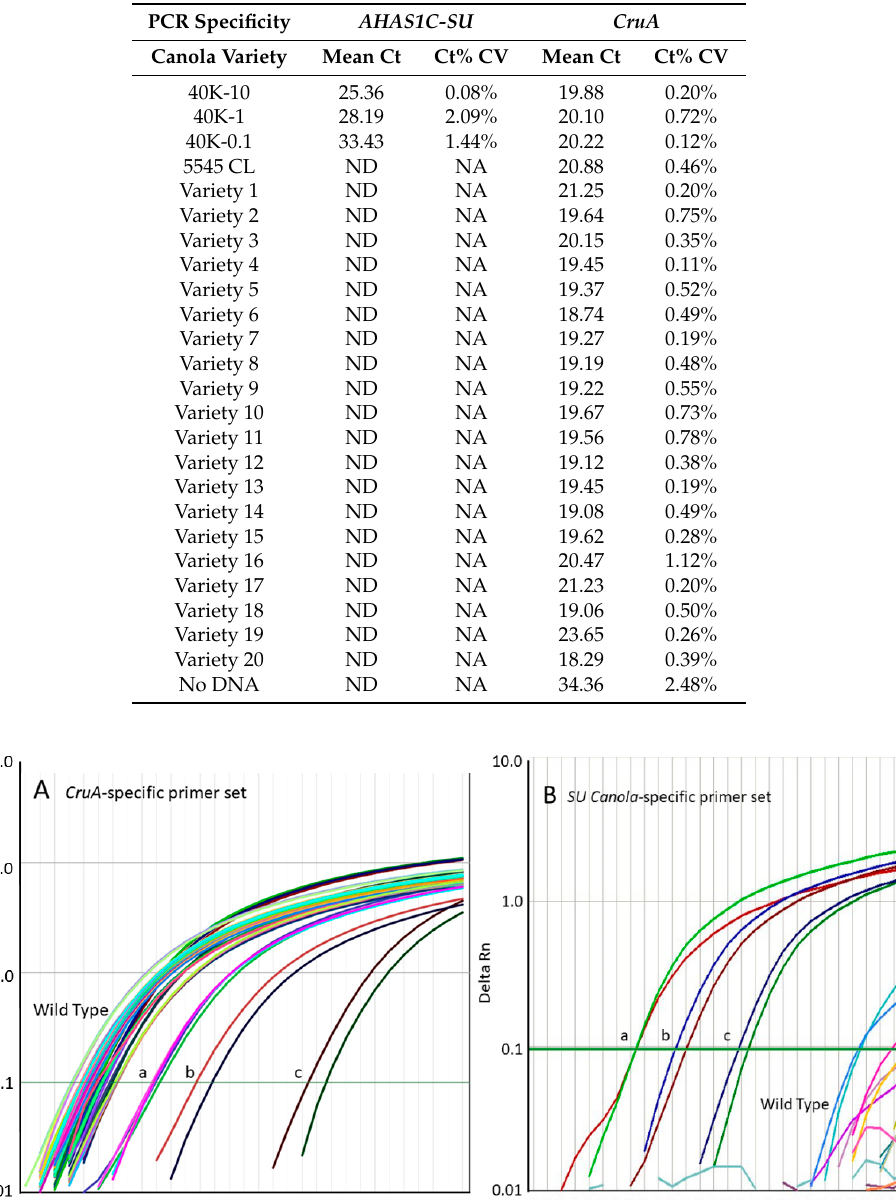
Table 3. Real-time qPCR amplification of DNA from SU canola event 40K, Clearfield canola variety 5545 CL and 20 varieties of wild-type canola with PCR systems specific for the CruA endogenous canola reference gene and the AHAS1C-SU SNV present in SU canola. PCR conditions are as described in Methods, with 300 ng input DNA per reaction for each variety except that the concentrations of DNA in the reactions labeled 40K-10, 40K-1 and 40K-0.1 were 300, 30 and 3 ng DNA of 40K DNA, respectively, with total DNA adjusted to 300 ng with DNA from canola variety 5454 CL for reactions 40K-1 and 40K-01. For all wild-type varieties, n = 4. ND indicates that no amplification was detected; NA indicates “Not Applicable” because no amplification was observed.